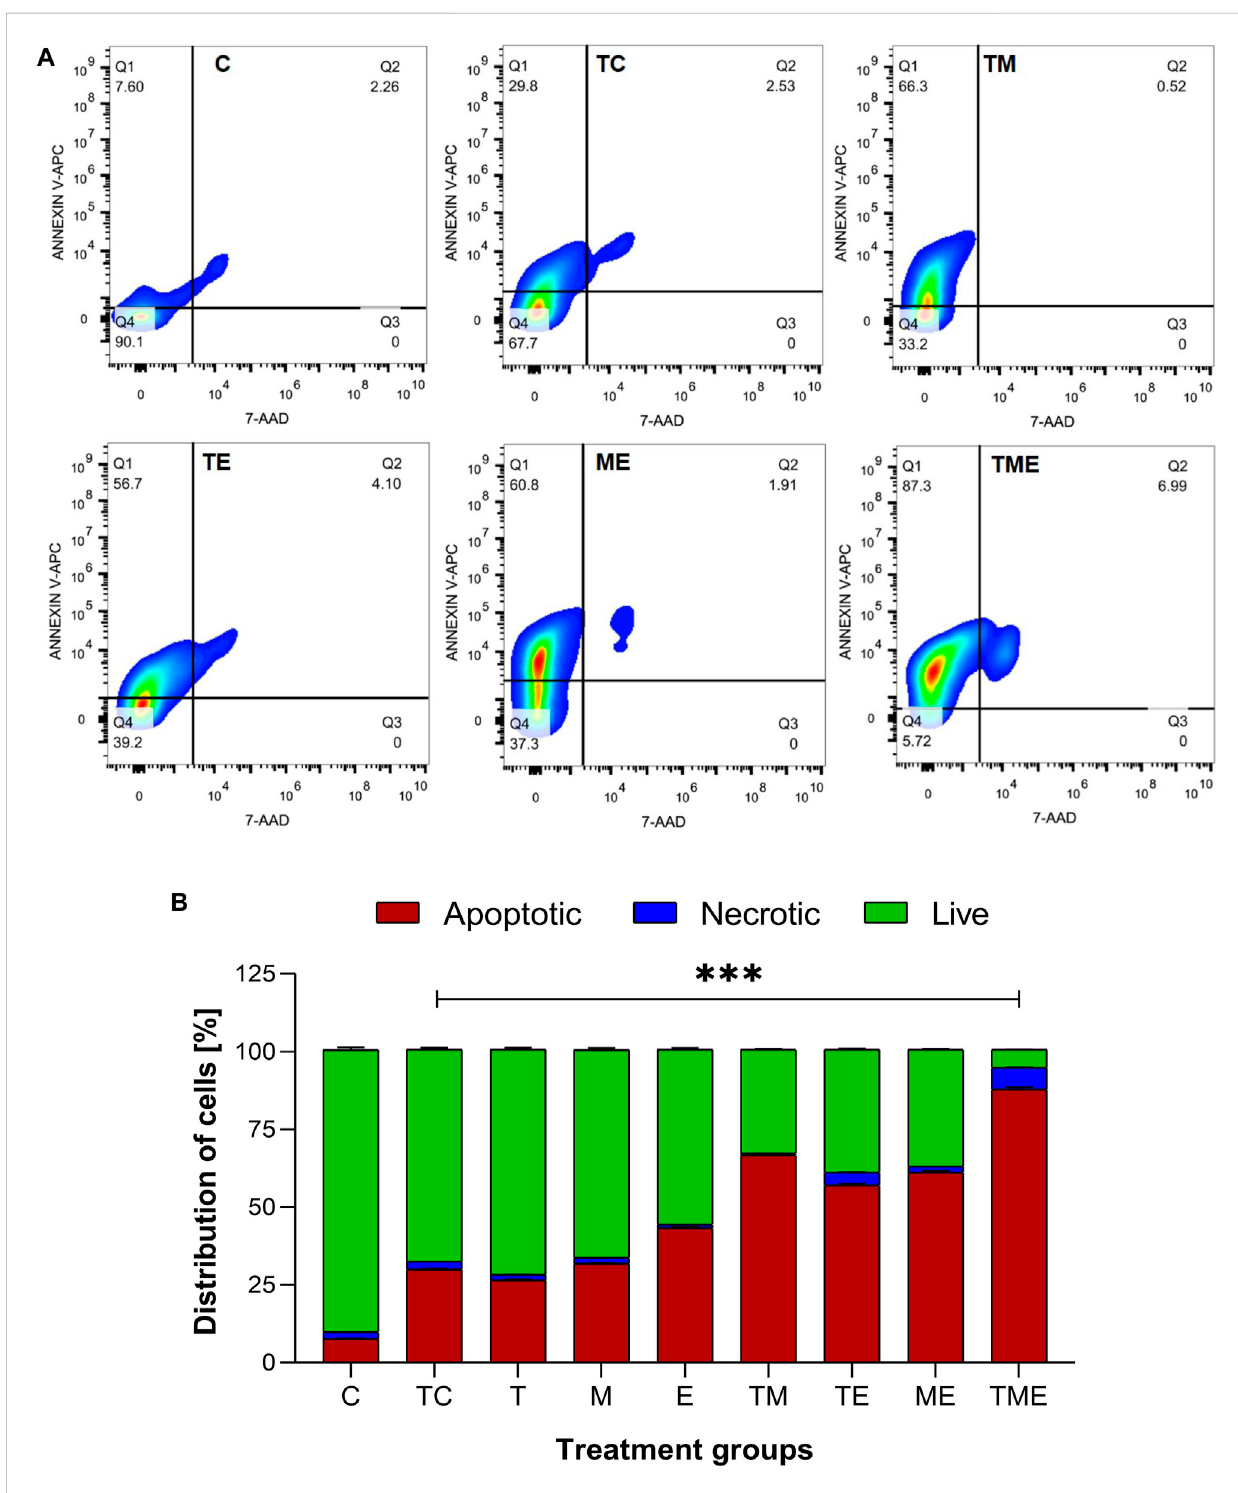
FIGURE 5 Apototis detection using ANNEXIN V- Flow cytometric analysis (A) The clustered bars represent total percentages of live, apoptotic and necrotic cellsforthevarioustreatmentgroups. (B) Representthecellpopulationinthe4differentquadrants(Q1-earlyapoptotic,Q2-necrotic,Q3-lateapoptotic and Q4- live cells). All the experiments were performed in triplicates, the data is represented as mean ± standard deviation and the signi fi cance was calculated using two-way ANOVA (*** P <